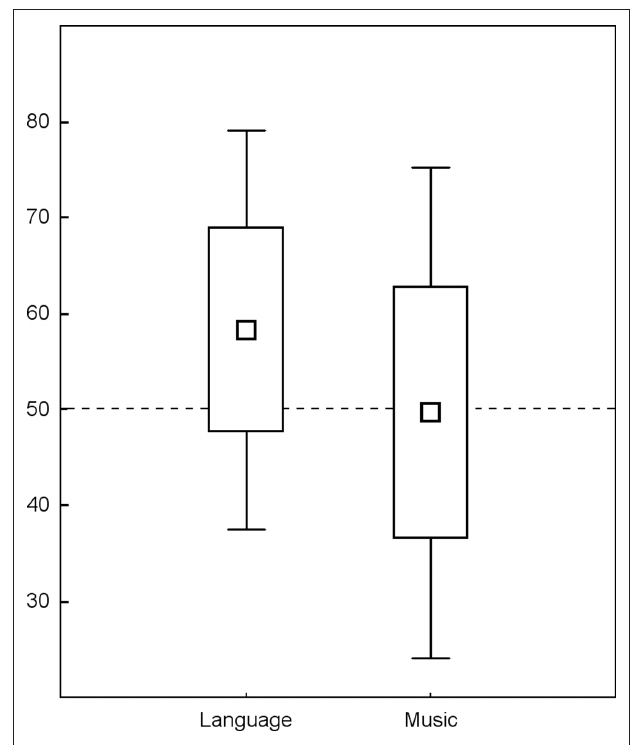
Figure 3 | Correlation between performances in the linguistic and musical tests for 50 participants (Francois and Schön, 2010, 2011). The correlation is significant ( p = 0.05), that is the better participants performance in the musical test, the better are performances in the